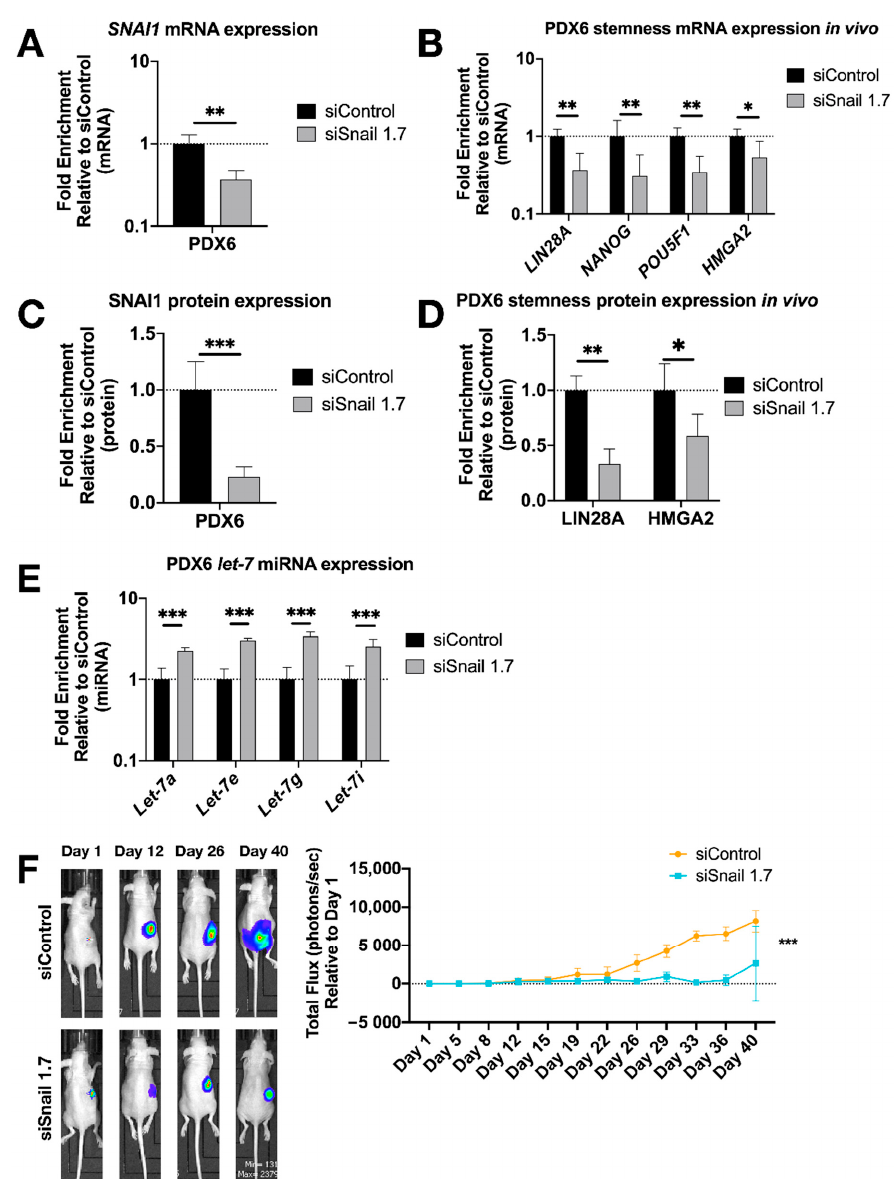
Figure 5. SNAI1 knockdown in vivo reduces stemness gene expression and tumor burden. HA-MSN were used to deliver siRNA (siSnail and siControl) via IV injection to orthotopic PDX in vivo. Tumor samples were harvested and analyzed at necropsy. Levels of control group (cells treated with siControl) were normalized to 1. Values for RT-qPCR are shown on a log scale. ( A , B ) RT-qPCR analysis for mRNA expression of SNAI1 ( A ) and of stemness markers LIN28A , NANOG , POU5F1 and HMGA2 ( B ), in tumors. ( C , D ) The quantification of Western blot analysis for protein expression of SNAI1 ( C ) and stemness markers LIN28A and HMGA2 ( D ), in tumors. ( E ) RT-qPCR analysis for let-7 miRNA ( let-7a , let-7e , let-7g and let-7i ) expression in tumors. ( F ) Left panel: Representative images of xenograft mice. siControl (upper) and siSnail knockdown (lower). Right panel: Quantitation of bioluminescence at primary sites over six weeks. X axis, days; Y axis, total flux in photons/second relative to day 1. * p < 0.05; ** p < 0.01; *** p < 0.001.